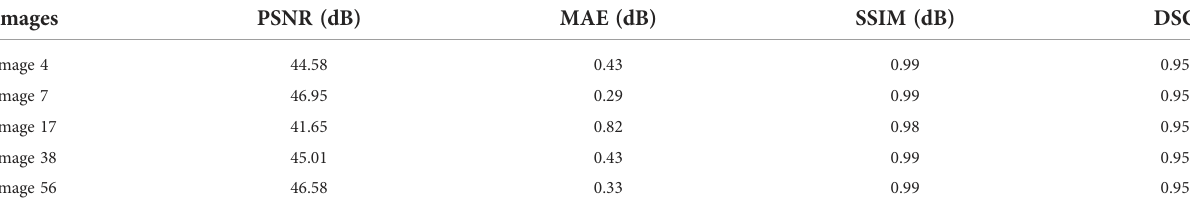
TABLE 3 Comparison on PSNR, MAE, SSIM, and DSC for fi ve morphological gradient (MG) images. Images